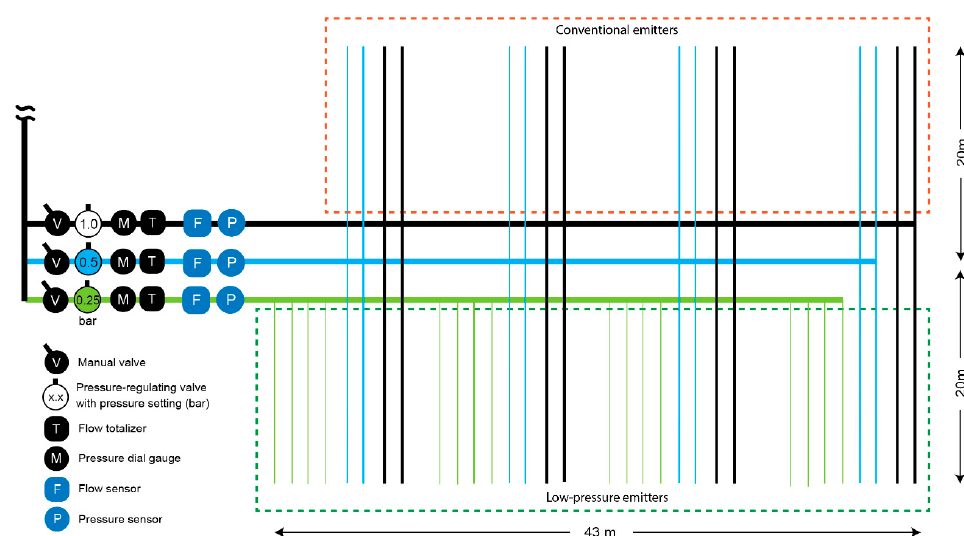
Figure A2. Site diagram for the treated wastewater site (Ramtha Research Station) in Jordan. A pressure-regulating valve at the start of each submain was used to set a di ff erent pressure for each: 25, 50, and 100 kPa (0.25, 0.5, and 1 bar). The submains at 50 and 100 kPa (0.5 and 1 bar) delivered water to 16 laterals each—8 with low-pressure emitters, 8 with conventional emitters. The submain at 25 kPa (0.25 bar) delivered water to 16 laterals with low-pressure emitters only, because it was far below the recommended operating pressure for conventional emitters.